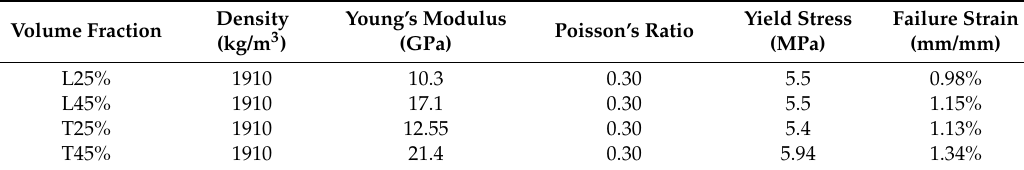
Table 1. Material Model